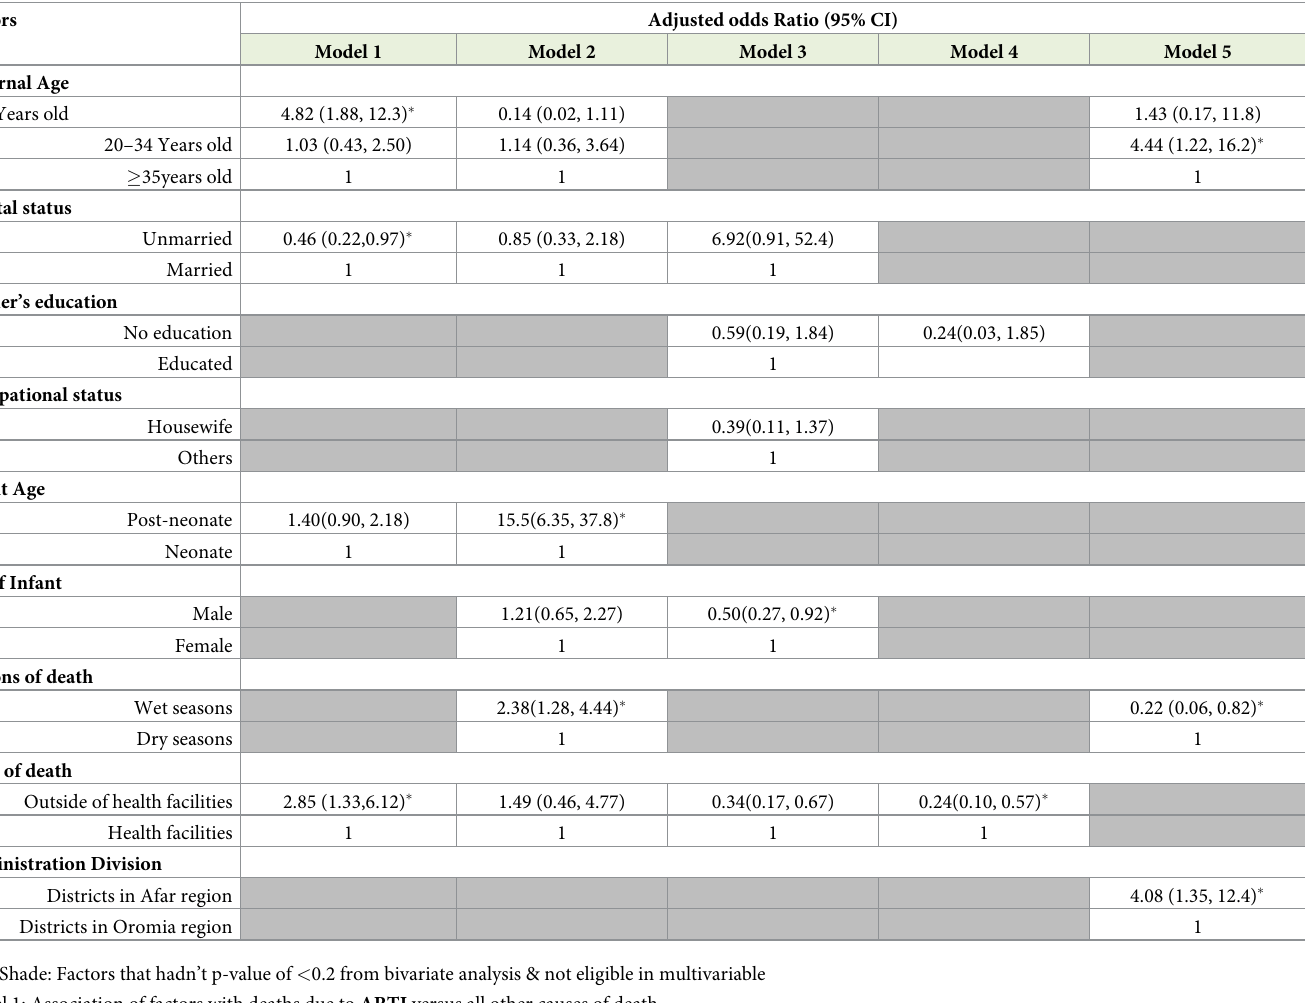
Table 3. Multivariable logistic regression analysis of factors associated with cause-specific mortality against all other cause of infant death in Eastern Ethiopia, 2016–18.